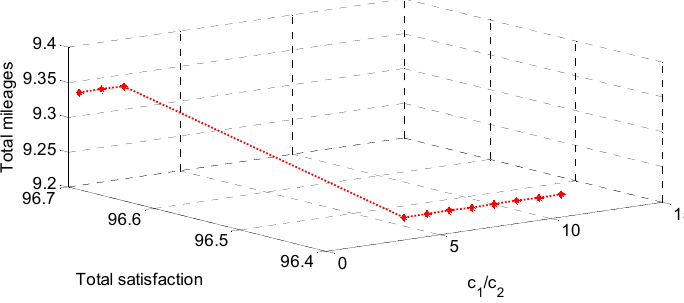
Figure 5. Influence of weight coefficient c 1 / c 2 on the scheduling result.